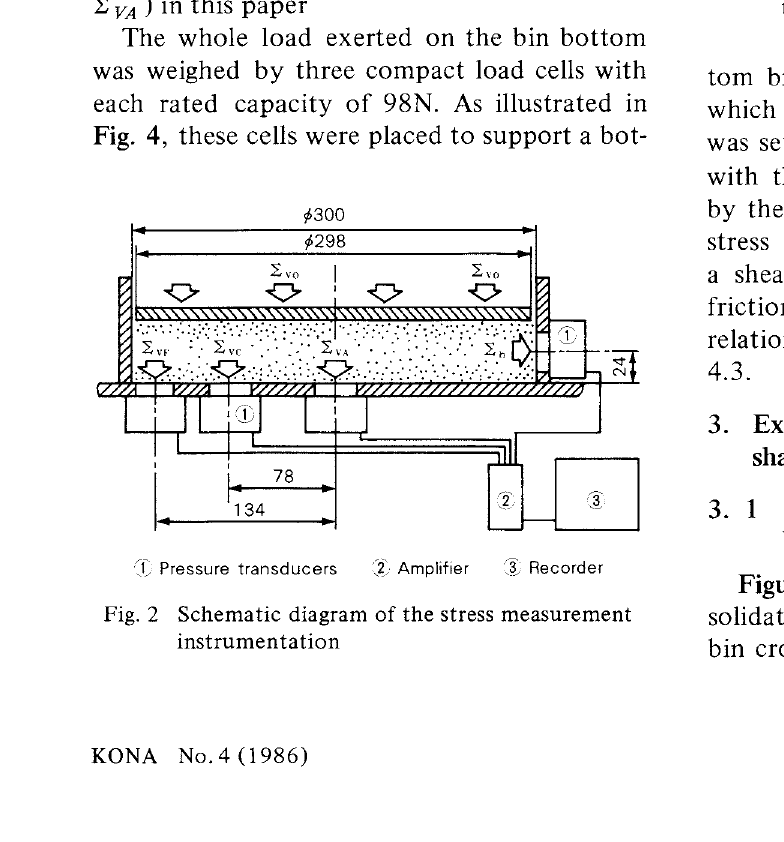
Fig. 4 Schematic diagram of the instrumentation used to measure the load acting on the bottom of the